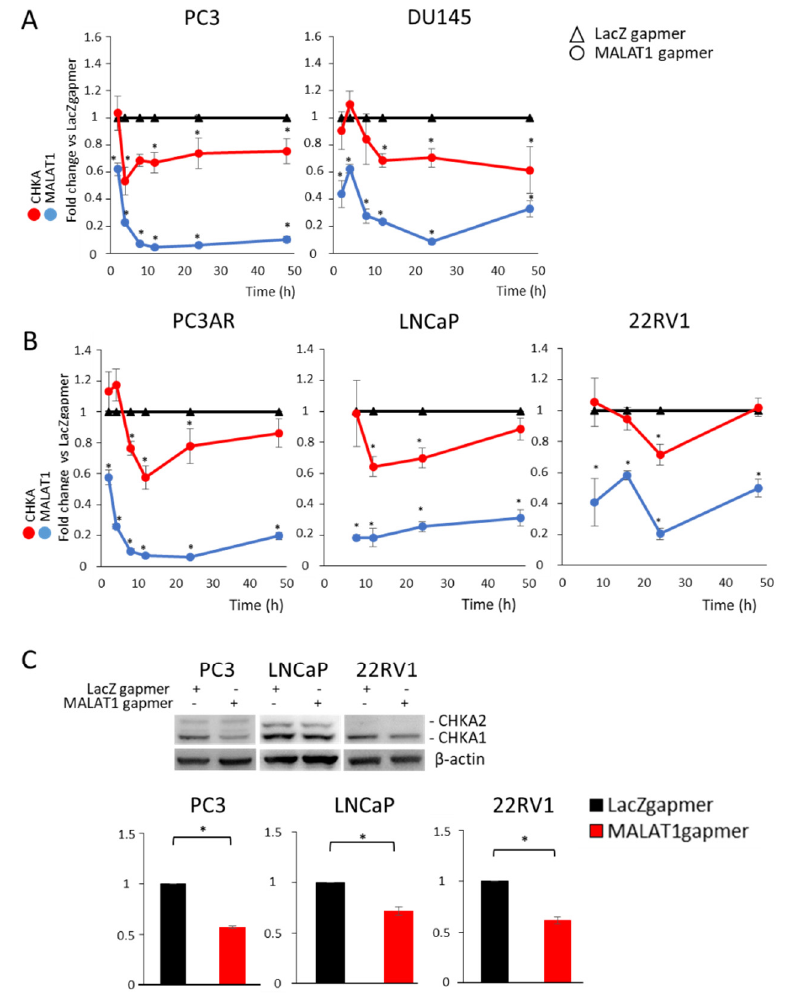
Figure 2. Effects on Choline kinase alpha (CHKA) expression in MALAT1-depleted PCa cells: ( A , B ) Quantification of CHKA and MALAT1 transcripts by qRT-PCR in androgen-independent (PC3 and DU145, ( A ), androgen-sensitive (PC3AR and LNCaP, ( B ), and androgen refractory (22RV1, ( B )) cell lines after transfection with specific (MALAT1) or control (LacZ) gapmers at different time points. LNCaP and 22RV1 cells were cultured with hormone-deprived (SS) serum. ( C ) Representative CHKA western blot and densitometry analysis in PC3, LNCaP, and 22RV1 cells after MALAT1 depletion (24 h in PC3 and 22RV1 and 16 h in LNCaP cells). β -actin was used as a loading control. Data represented